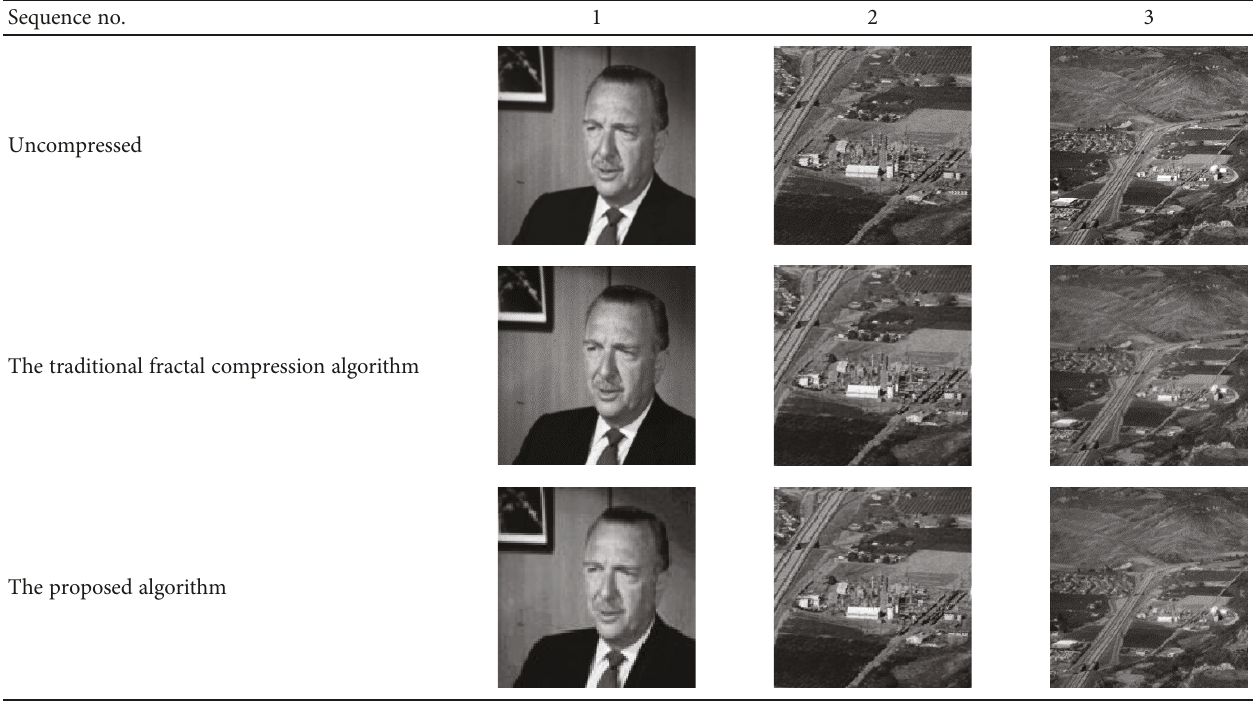
Table 3: Comparison of performance between traditional algorithm and proposed